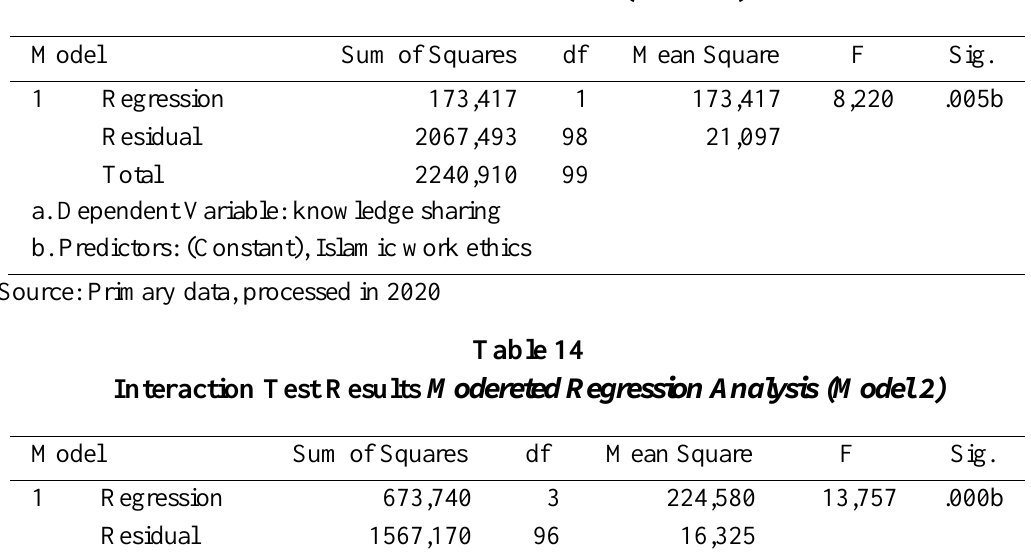
F Test Results Statistics (Model 1)